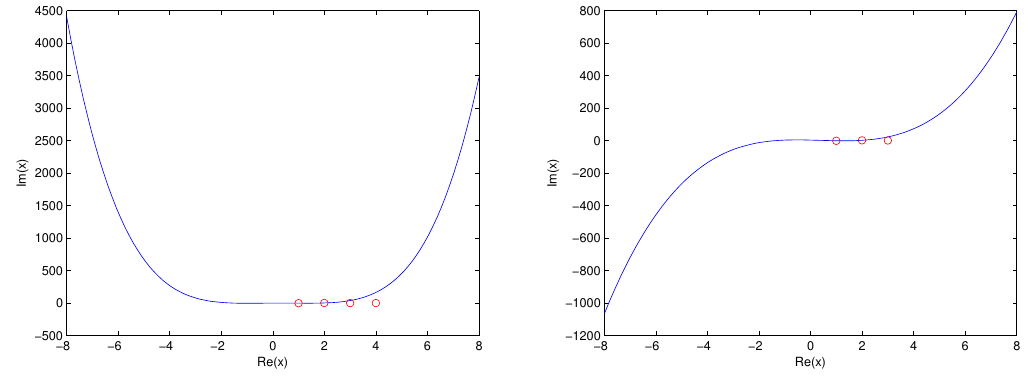
Figure 4. Shape and zeros of H E 4,1/2 ( x ) , Shape and zeros of H G 4,1/2 ( x ) .